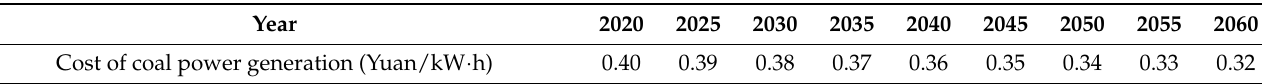
Table 9. Prediction of energy consumption cost in the future.